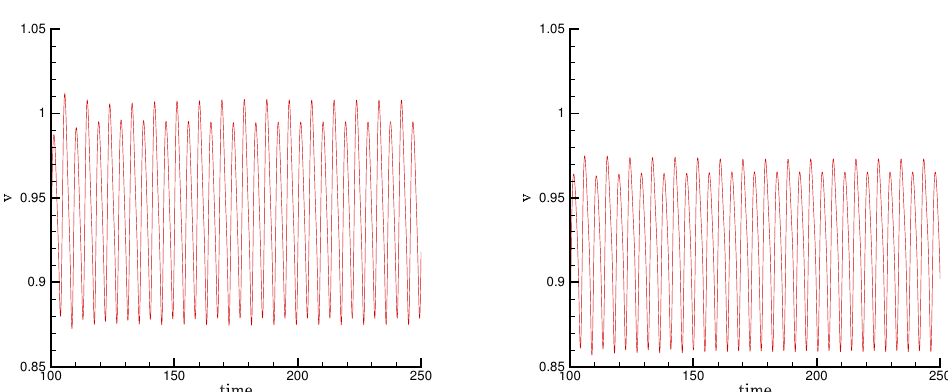
Figure 9. Time series of the velocity component v ( x p , t ) at x p = ( 10,0 ) in the time interval t ∈ [ 100,250 ] for an incompressible fluid with power-law index n = 1.5 without yield stress ( left ) and with yield stress σ y = 10 − 3 ( right ). In both cases the Strouhal number is St =